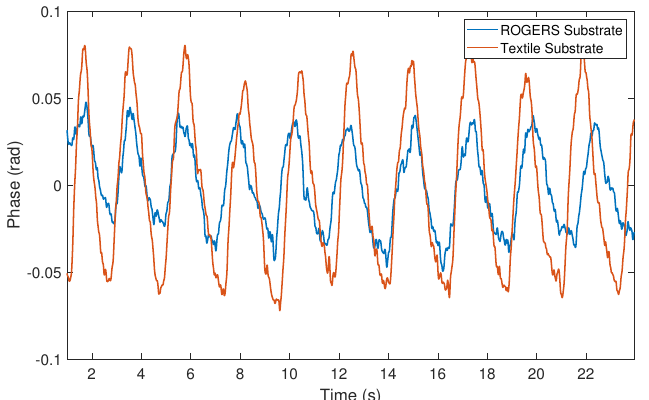
Figure 18. Comparison of the respiratory signals acquired using conventional and textile substrate